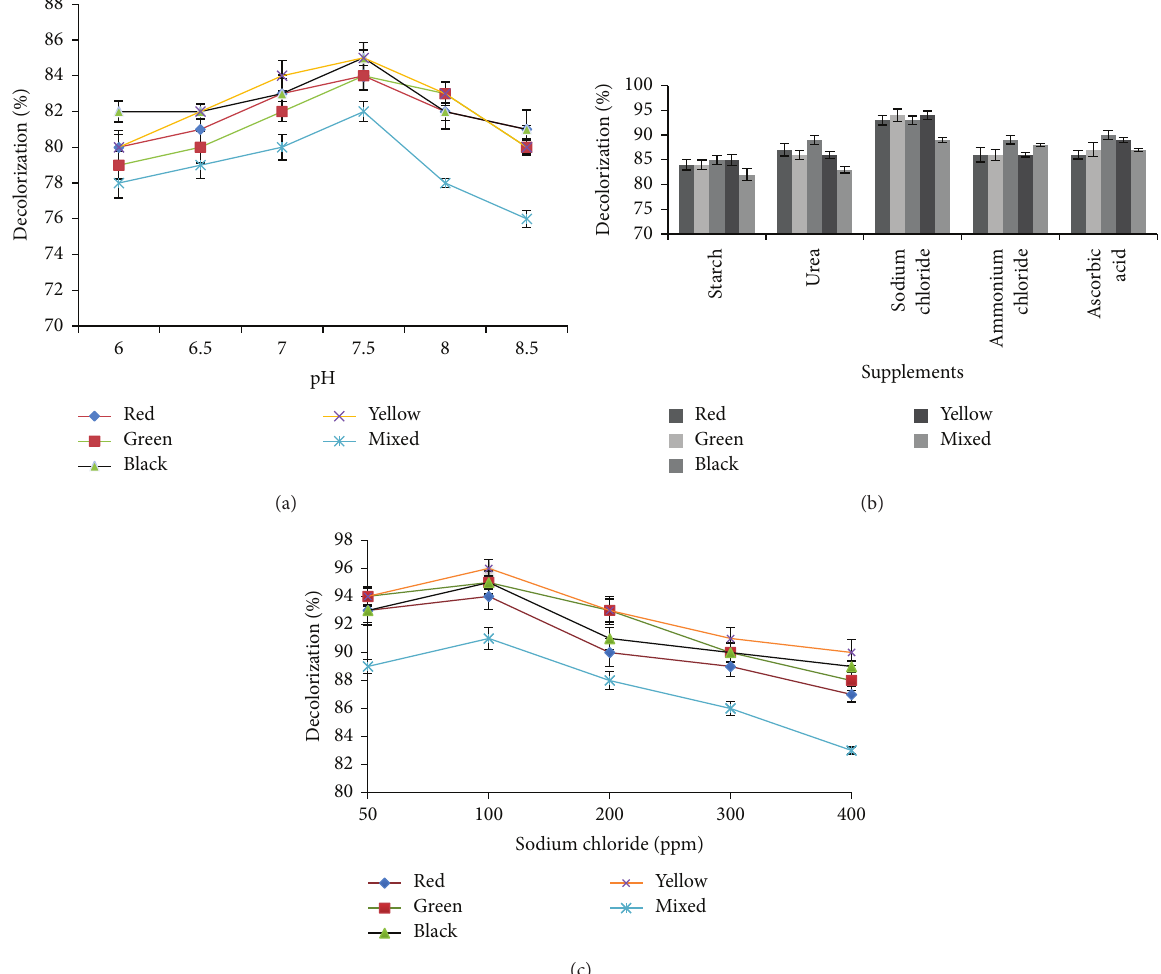
Figure 1: Effect of pH (a), supplements (b), and sodium chloride (c) on decolorizing ability of consortium.